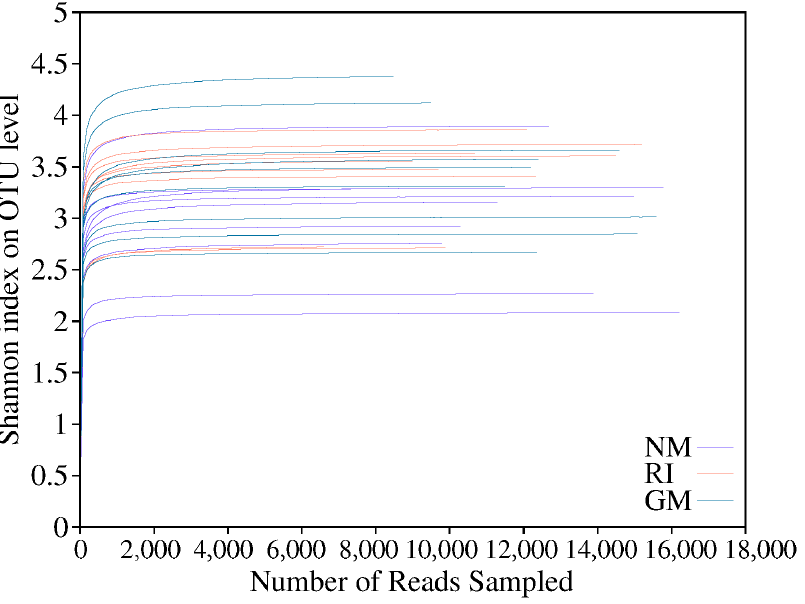
Figure 2. The rarefaction curves of bacterial community on OTU level under different heavy metal stress.